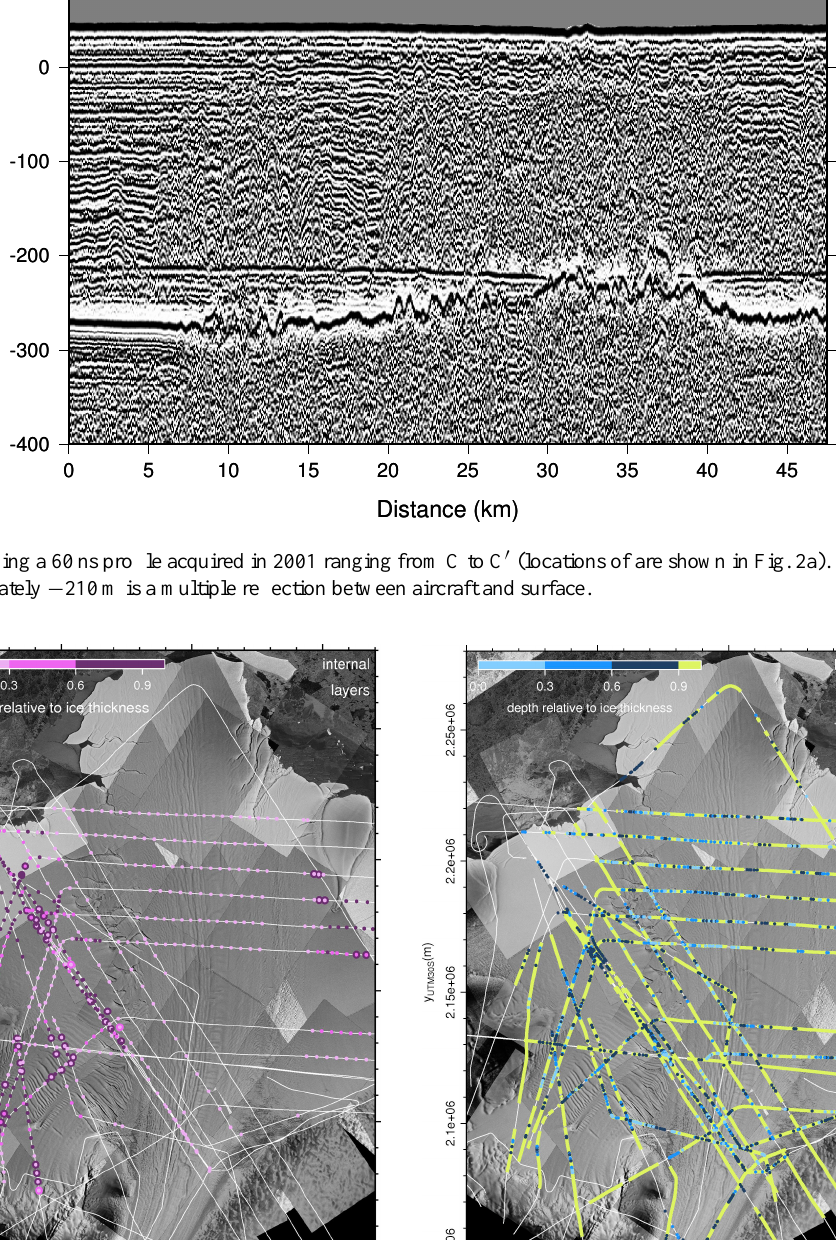
The Cryosphere, 5, 931–944,